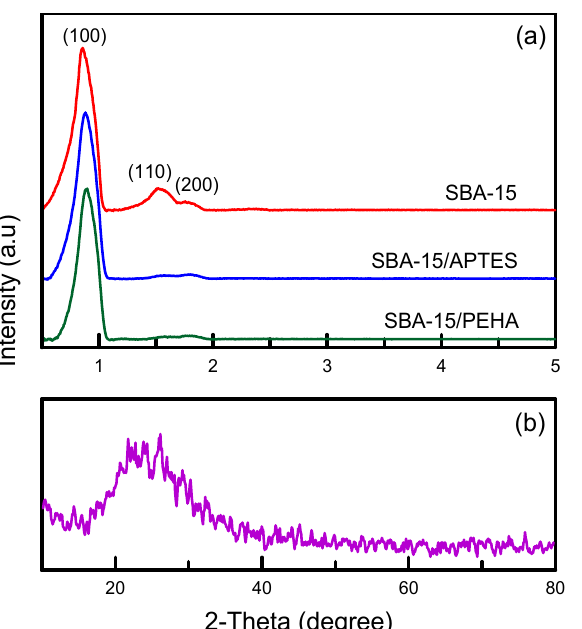
Figure 3. ( a ) XRD images of unfunctionalized and amino ‐ functionalized silica samples; ( b ) SBA ‐ 15 sample.